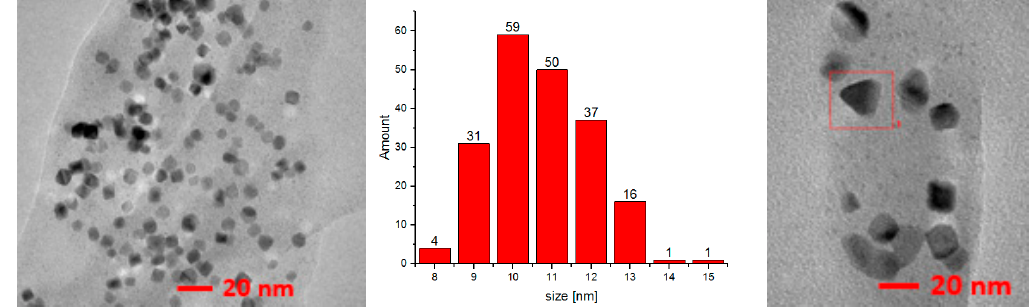
Figure 9. Morphology and size distribution of C4 Pd/DNA.